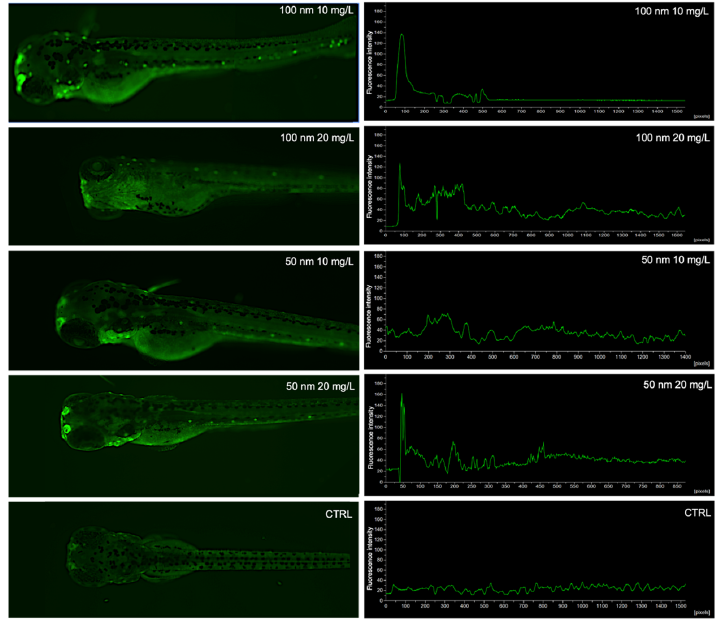
Figure 5. Localization of apoptotic cells on D. rerio larvae exposed to nPS ‐ NH 2 and on control. The graphs show the fluorescence intensity, the peaks of which correspond to cells in active apoptosis.